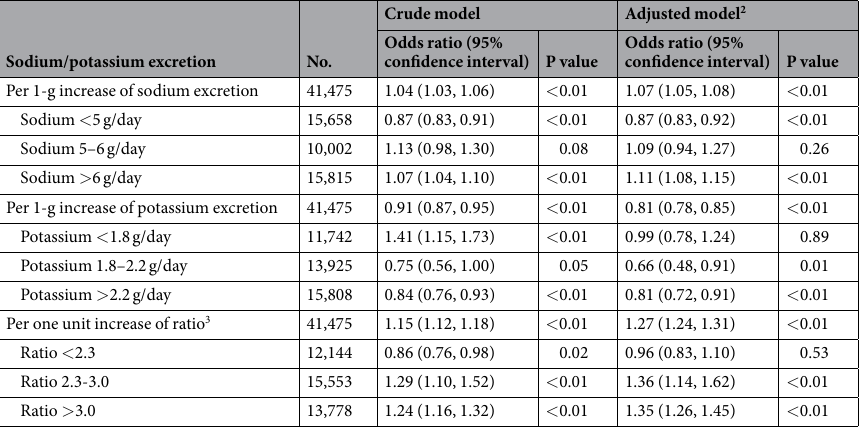
Table 4. Adjusted associations of hypertension prevalence with 24-hour urinary sodium and potassium excretion per one-unit increase. 1 Self-reported hypertension or had blood pressure medication or blood pressure ≥ 140/90 mmHg; CI, confidence interval; 2 Adjusted for gender, age, education level, geographic region, body mass index (BMI), and alcohol intake; 3 Ratio means 24-hour urinary sodium excretion divided by 24- hour urinary